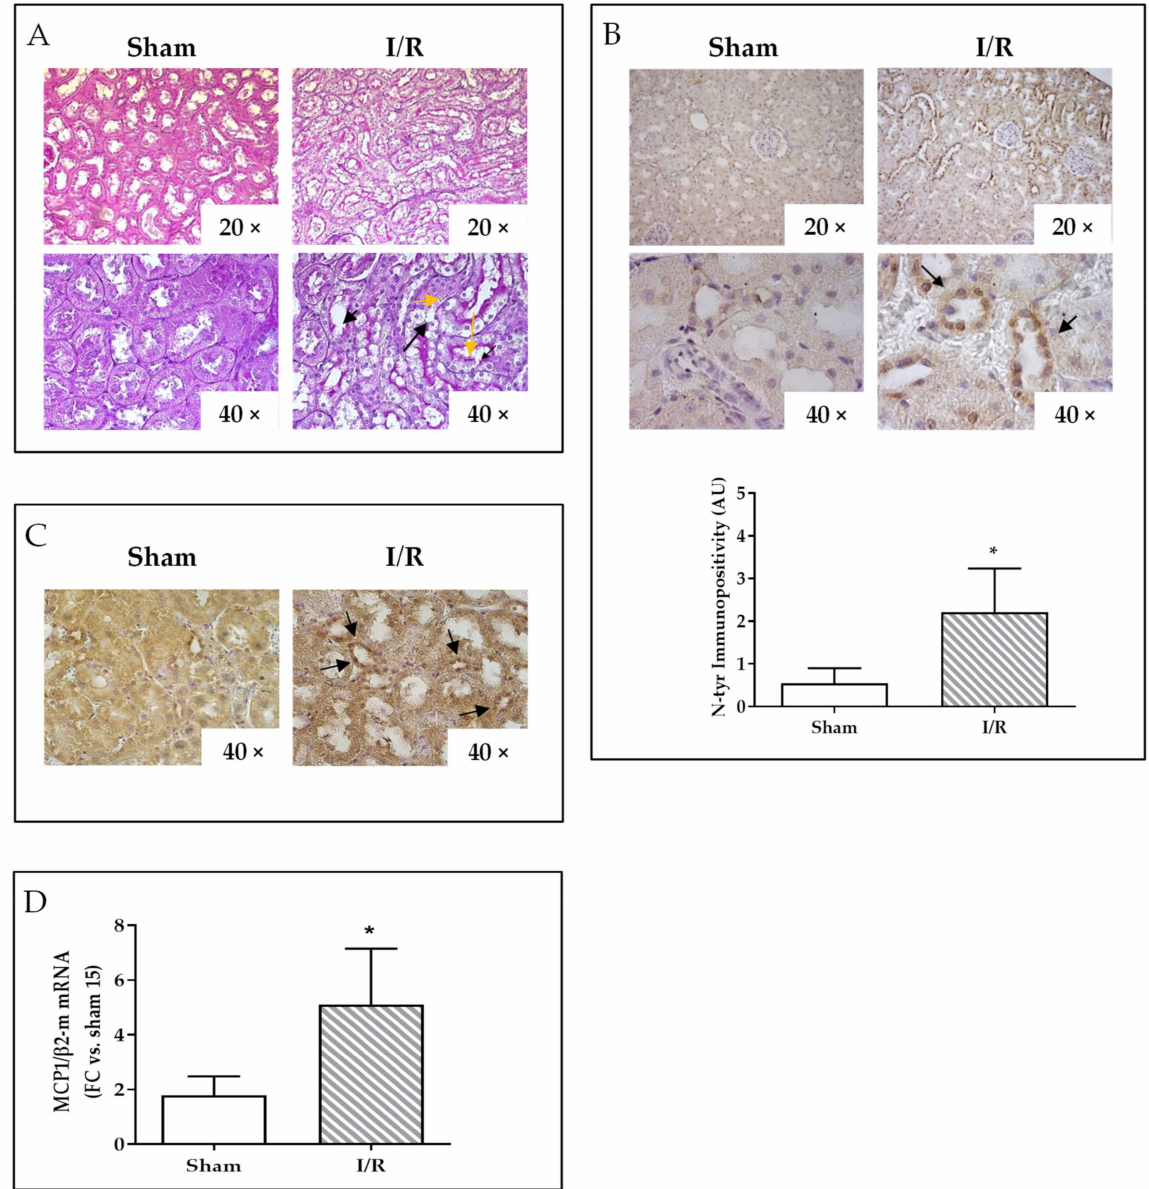
Figure 2. Analysis of rat kidneys after sham intervention or ischemia/reperfusion (I/R, 30 min/24 h). ( A ) PAS staining showing areas of tubular necrosis in I/R kidney (right panels): yellow arrows indicate swollen cells and black arrows indicate the site of cell loss within the tubuli. ( B ) N-tyr immunostaining, representative images (top) and image analysis quantification (bottom); * p < 0.05. ( C ) PGC-1 α immunostaining: black arrows display the nuclear positivity in representative images. ( D ) MCP-1 mRNA expression after 24 h of reperfusion by quantitative real-time PCR. The results have been normalized by expressing the number of transcript copies as a ratio to β 2-microglobulin ( β 2-m) and indicated as fold changes (FC) in respect to kidneys from sham-operated rat (#15); * p <